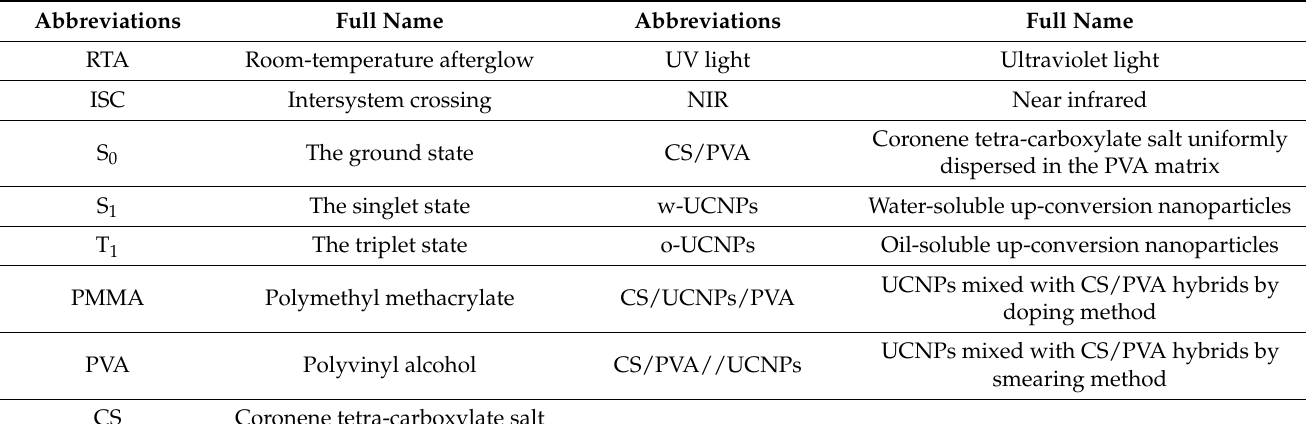
Table 1. A list of abbreviation instructions in the